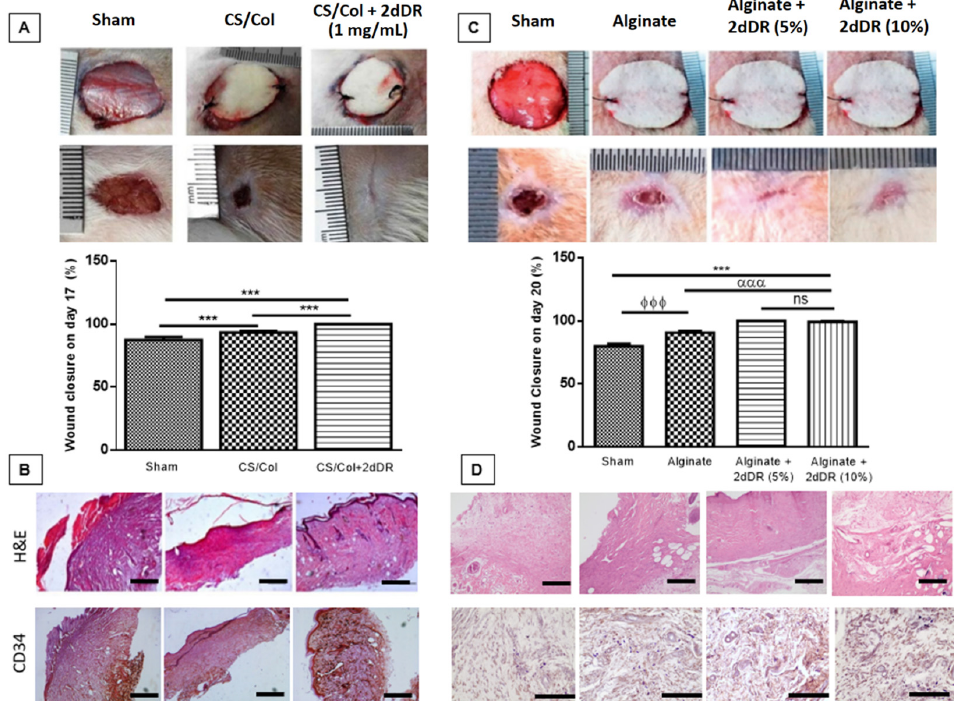
Figure 4. Gross, histological and graphical representation of wound closure analysis of animal studies. ( A ) Macroscopic analysis and ( B ) H&E staining and immunostaining with CD34 marker of the wounds showing the healing of cutaneous wounds in 17 days when treated with 2dDR-loaded CS/Collagen hydrogels (n = 3). ( C ) Macroscopic analysis and ( D ) H&E staining and immunostaining with CD34 marker showing the healing of diabetic wounds in 20 days when treated with 2dDR- loaded alginate dressings (n = 4). Scale bars represent 100 µm. Results are presented as mean ± SD where *** p < 0.001, ϕϕϕ p < 0.001, ααα p < 0.001, ns p > 0.05 (not significant). Images, used in ( A , B ), are adapted from [29] with permission granted by Materials Today Communications, Copyright 2017 Elsevier. Images, used in ( C , D ), are adapted from [33] with permission granted by Journal of Bio-